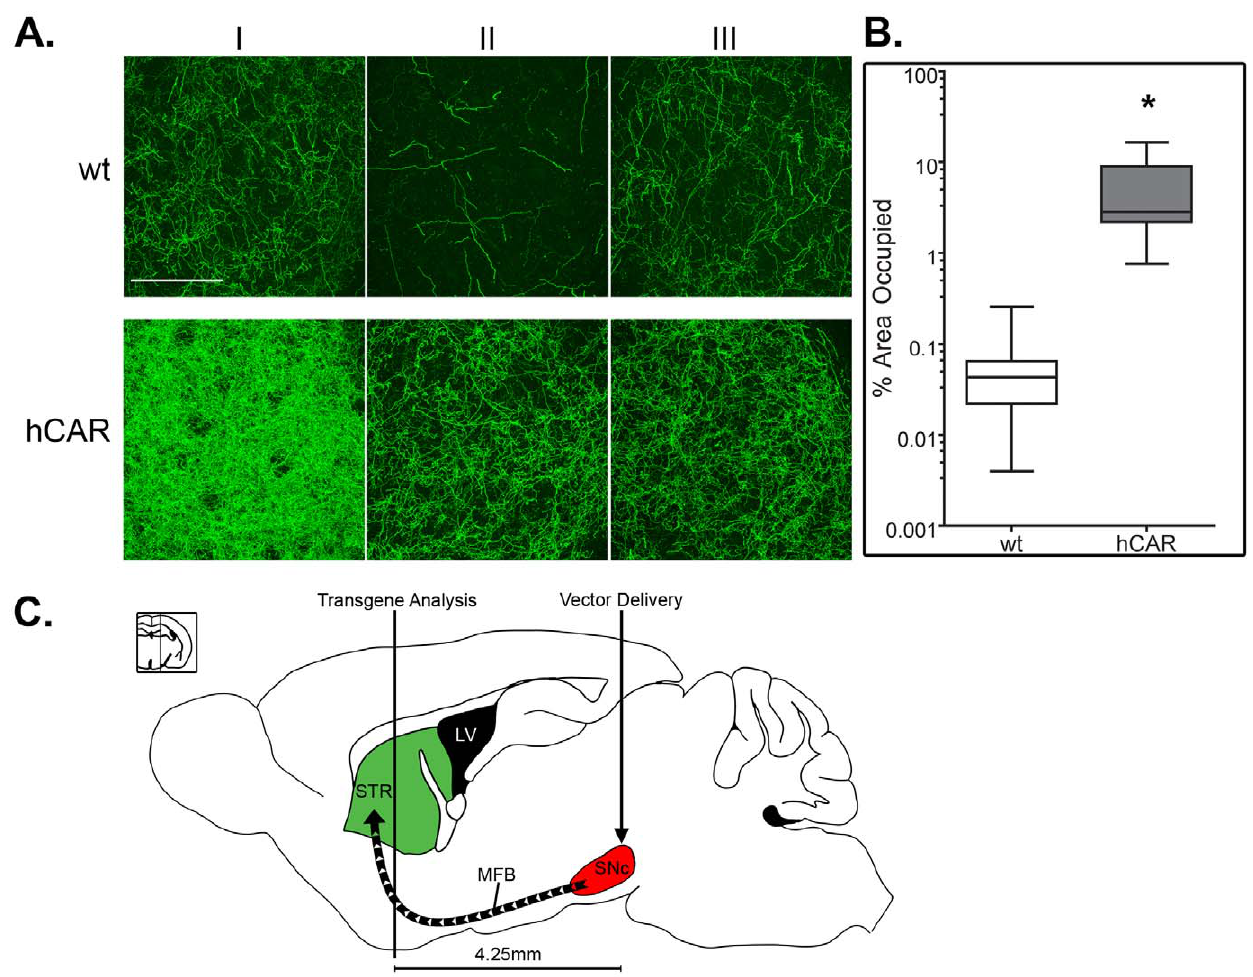
Figure 4. Quantitation of transgene in the striatal terminal fields. Densitometric analysis of transgene expression in the STR shows the CAR- dependence for transduction of SNc dopaminergic neurons by Ad delivered to the ventral midbrain. ( A ) Representative flattened confocal z-stacks through a 35 m m section of the dorsolateral STR in three wt and hCAR animals. GFP-filled axons projecting from the SNc show the level of neuronal transduction that is augmented by the addition of hCAR transgene. ( B ) Densitometric quantification of individual confocal z-planes shows a significant increase in Ad5 transduction capacity in hCAR mice. ( C ) Drawing of a sagittal section through the mouse brain shows the location of vector delivery in the SNc and the location of transgene expression analysis in the STR, approximately 4.25 mm distal from the site of injection. Scale bar in A =150 m m, Green = GFP. Box plot in B depicts sample minimum, 1 st quartile, median, 3 rd quartile and sample maximum. Statistical significance assigned using two-tailed Student’s t -test (* indicates P , 0.0001). LV = left ventricle, MFB = medial forebrain